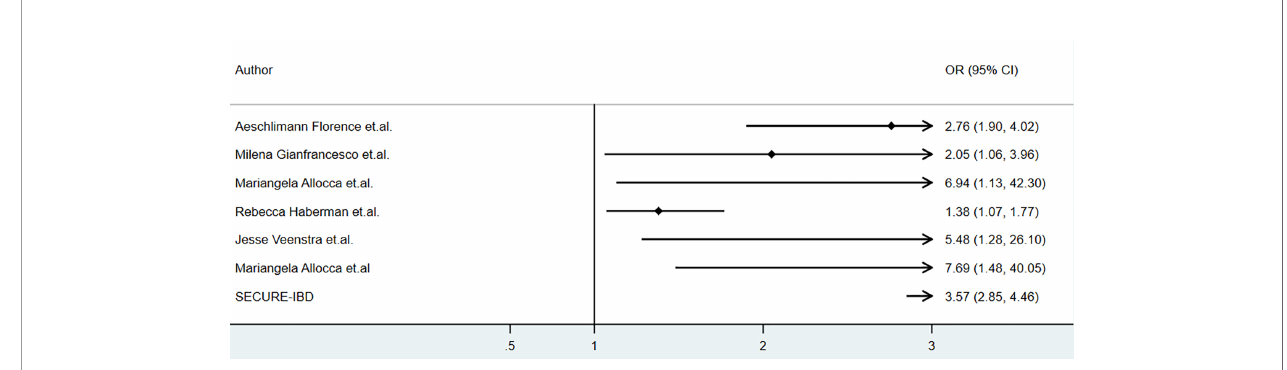
FIGURE 1 | The association of corticosteroids and clinical outcomes of COVID-19 among patients with immune-mediated in fl ammatory disease